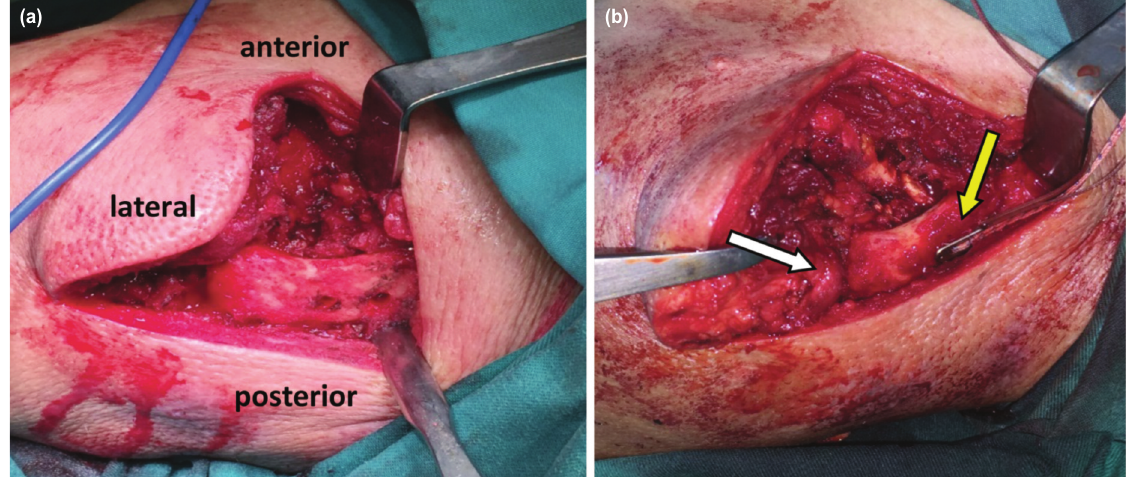
(a) Two clavicular tunnels, around 1 cm apart drilled around 2.5cm lateral to the acromioclavicular joint to restore anatomical Fig. 3: position of conoid and trapezoid ligament. (b) The graft was secured with GraftMaxTM button (Conmed Inc, Utica, NY) (yellow arrow). Intraoperative assessment of reduced acromioclavicular joint showed no anteroposterior and superoinferior translation (white